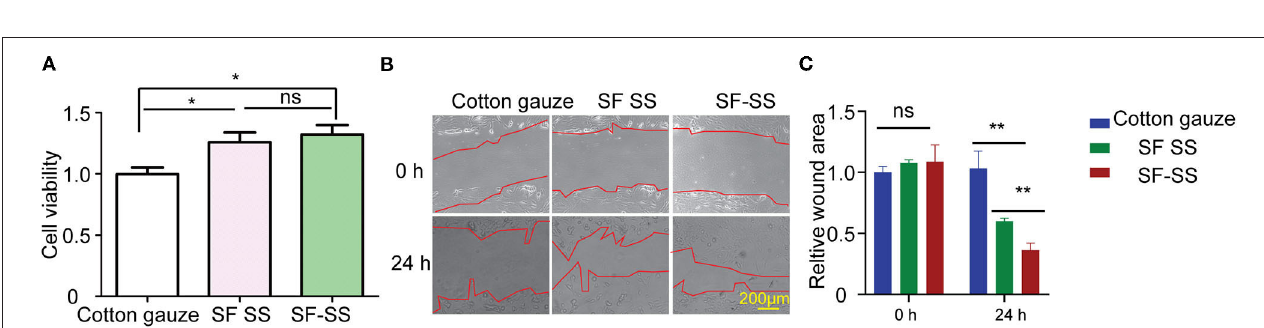
FIGURE 1 | Isolation and identification of UMSC-Exo. (A) Western blot analysis of CD9 and CD63 and GAPDH protein expression in UMSC and UMSC-Exo. (B) The expression of CD63 in UMSC-Exo was analyzed by flow cytometry. (C) Nanoparticle size distribution of UMSC-Exo. (D) The BJ cell viability was detected by CCK-8 after treatment with UMSC-Exo. Data is shown as mean ± standard deviation ( n = 3). ** p < 0.01, *** p < 0.001.